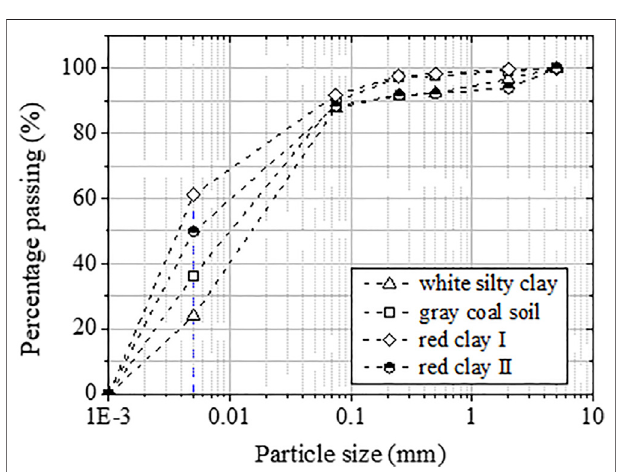
FIGURE 2 | Particle size distribution curves of several residual